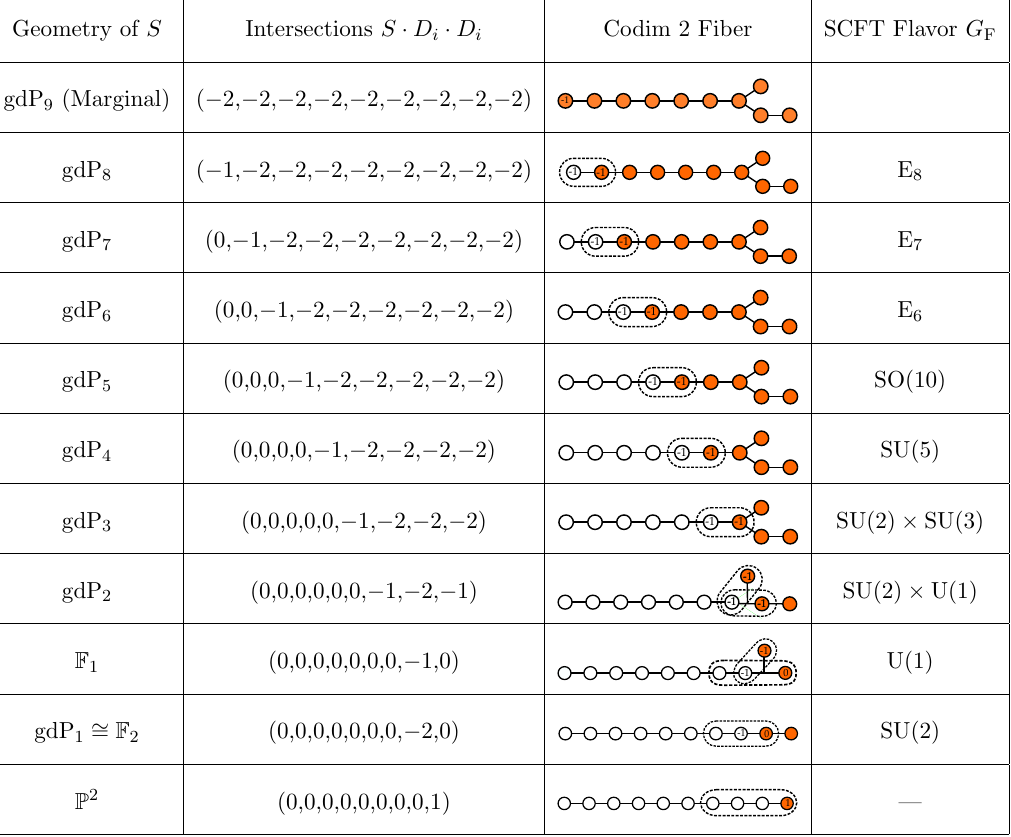
Table 1 . Geometries for rank one 5d SCFT: the table contains the geometry of the non-(cid:13)at surface component S in the elliptic (cid:12)bration, the intersection of S with the Cartans D i , i = 0 ; (cid:1) (cid:1) (cid:1) ; 8 of the E 8 (cid:12)ber; the codimension two (cid:12)ber, where the dotted lines show the splitting of the codimension one rational curves of the II (cid:3) (cid:12)ber that become reducible. Futhermore, the marked nodes are contained in the non-(cid:13)at (cid:12)ber S . Full colored nodes that remain irreducible in codimension two correspond to ( (cid:0) 2) curves in the II (cid:3) (cid:12)ber and contribute to the (cid:13)avor symmetry of the SCFT, G F